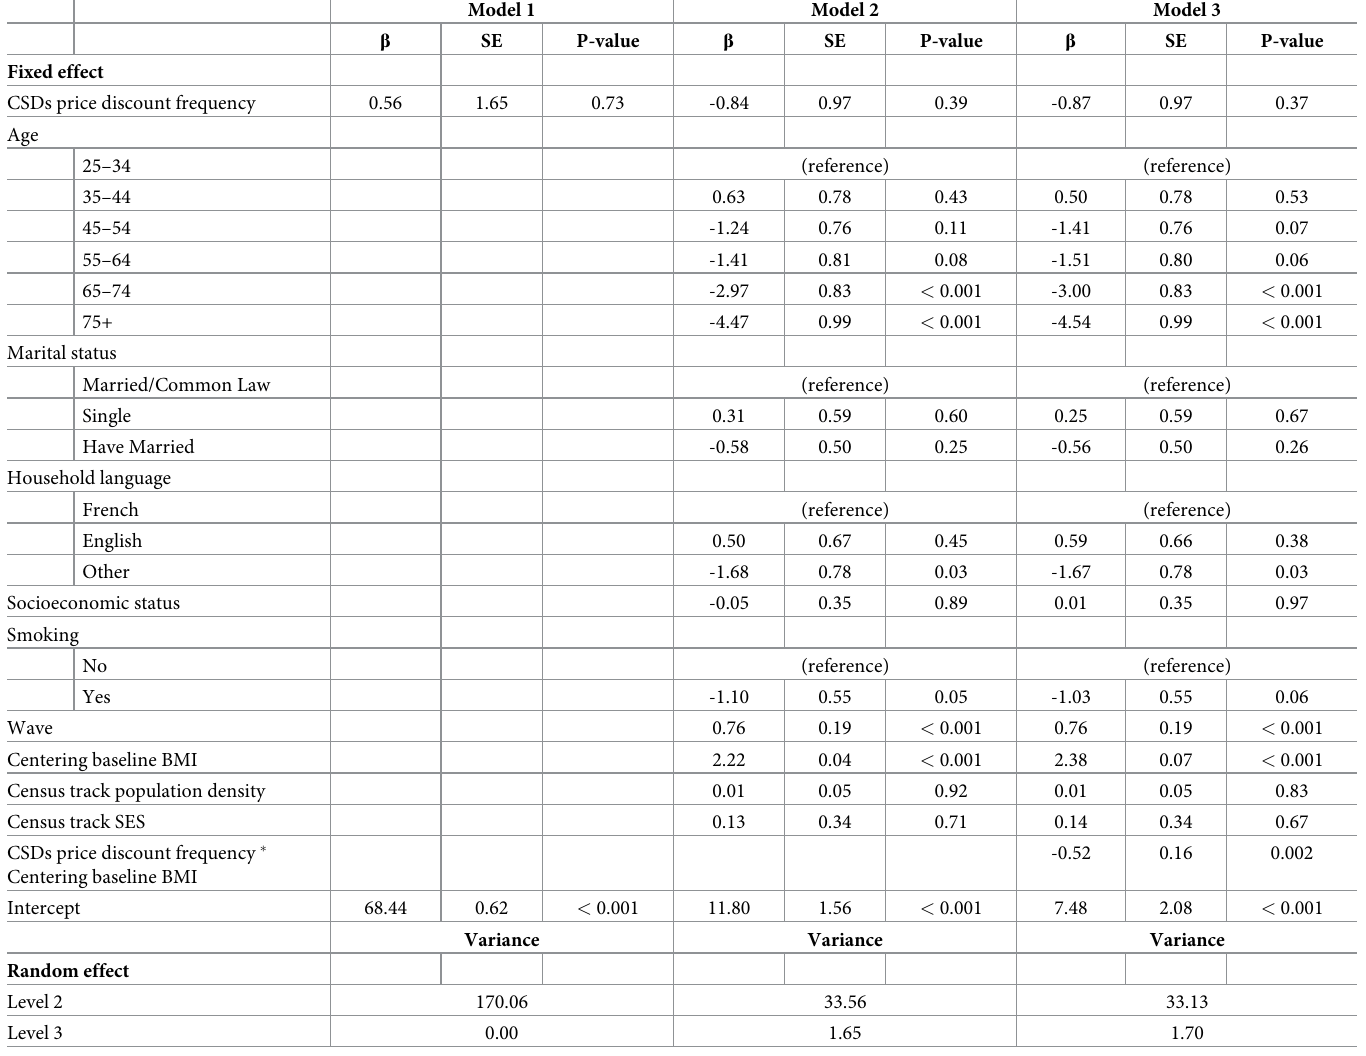
Table 2. Results of regression analyses examining the association between Carbonated Soft Drinks (CSDs) price discount frequency and women’s weight (kg), n = 1,622.